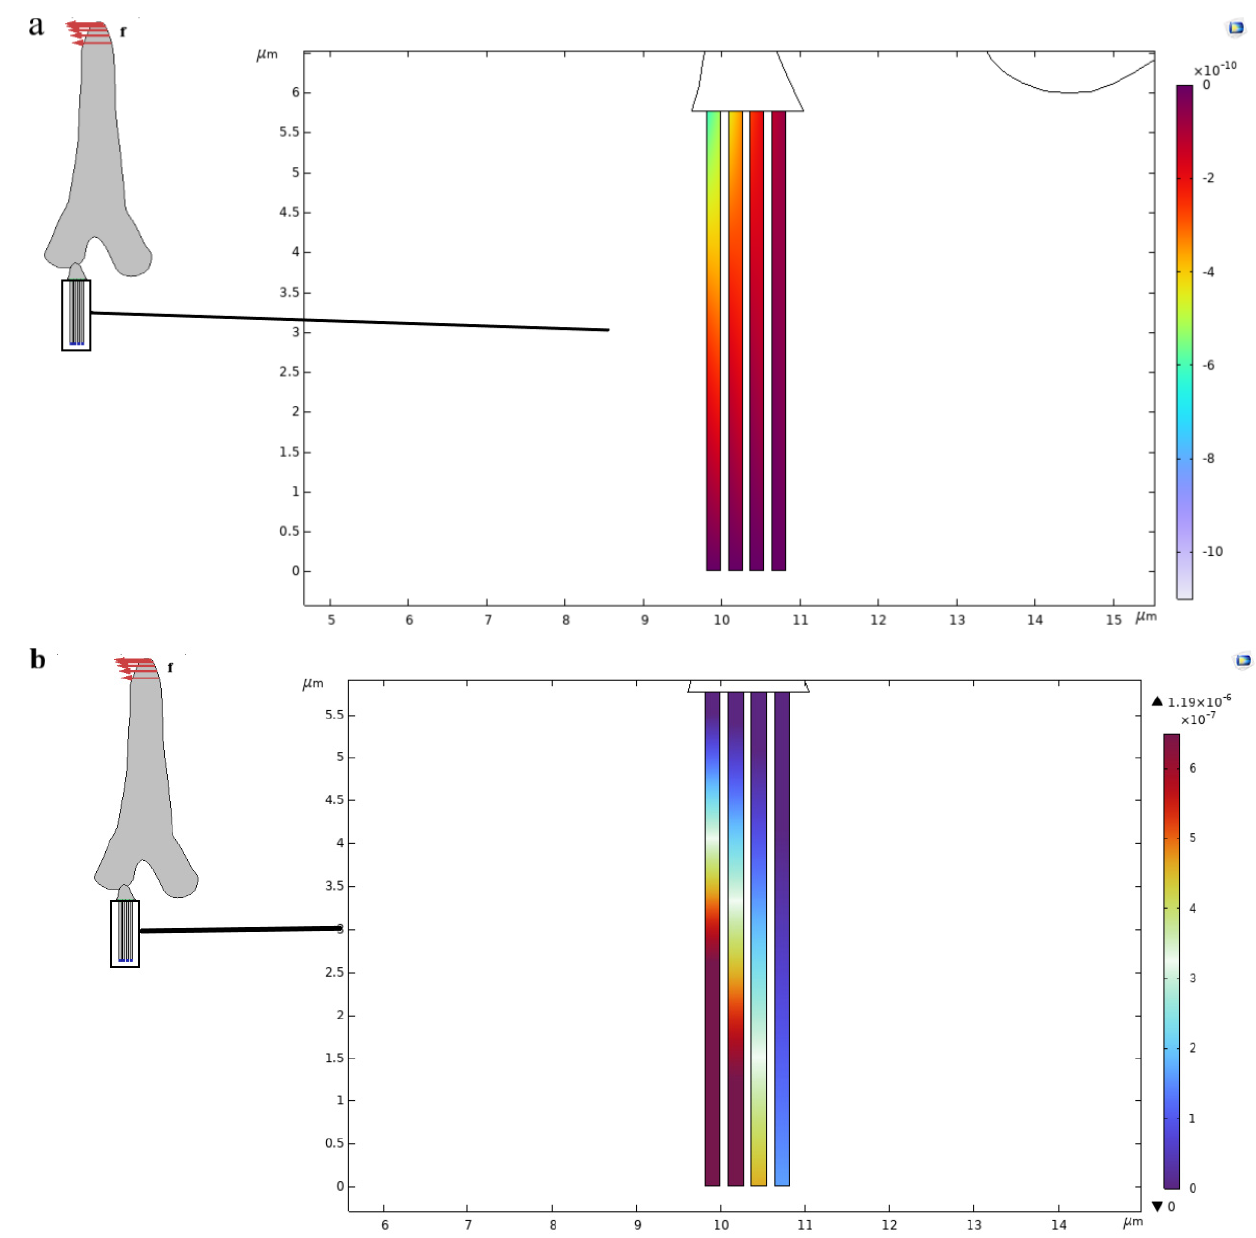
Figure 7. Electro-elastic response of the Tubular body. ( a ) Displacement field of the microtubules